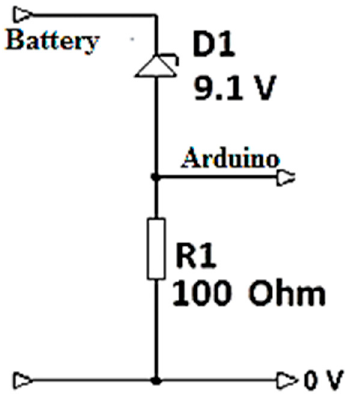
Figure 3. A simple voltage sensor circuit.